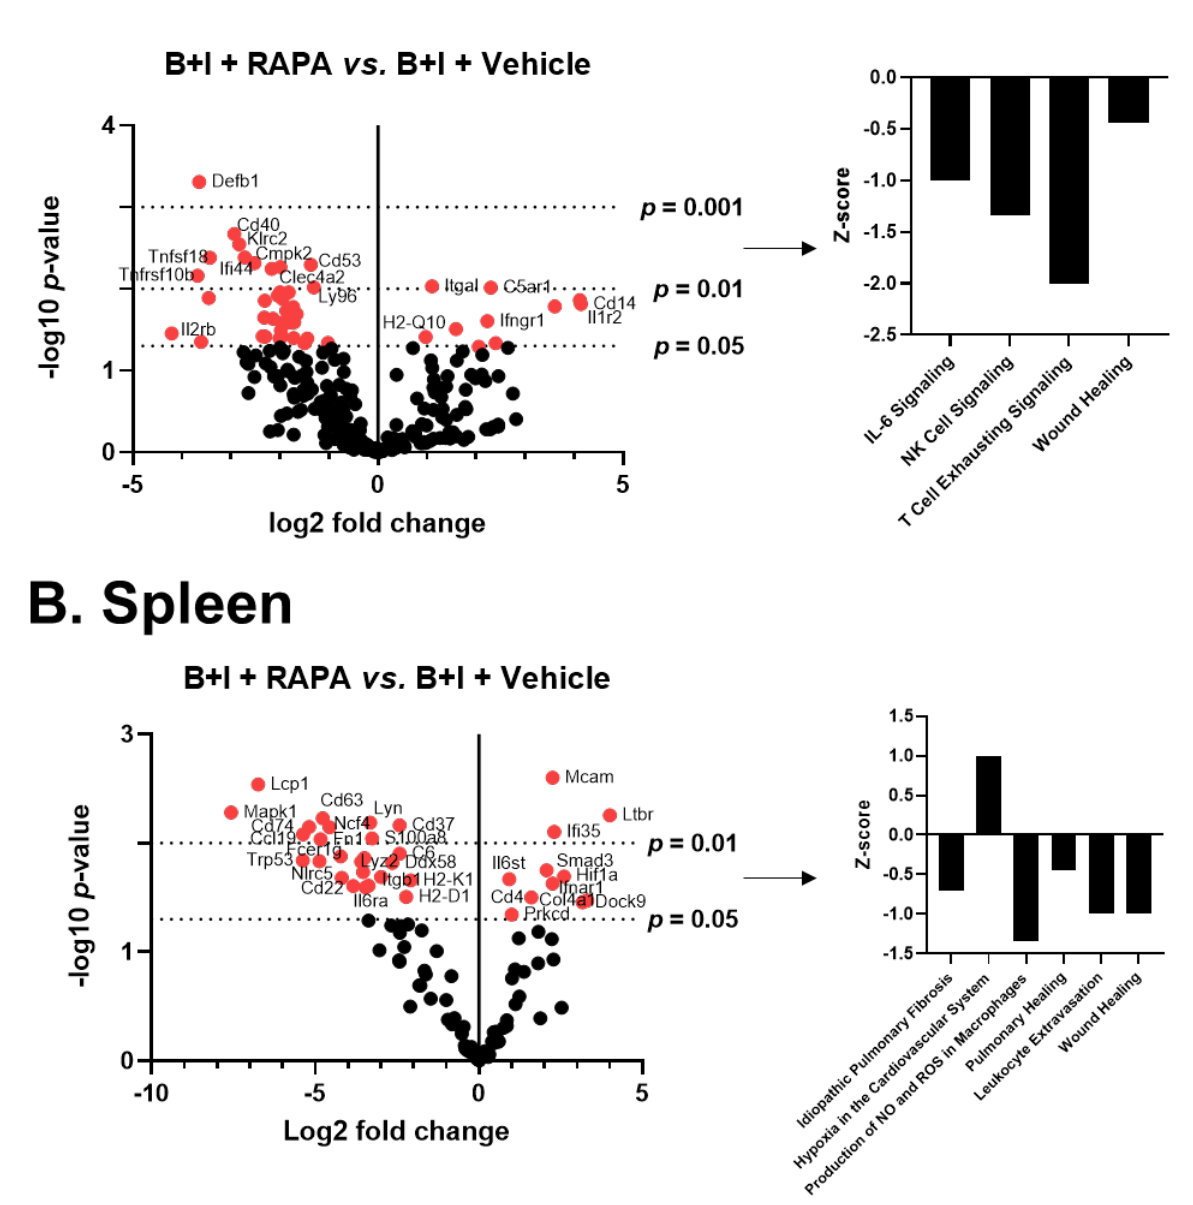
Figure 7. mTOR inhibition via rapamycin at the time of injury induced early differential gene expression and canonical pathway activity in B+I mice compared to vehicle controls. Mice were administered either rapamycin or vehicle pretreatment for 7 days before receiving B+I injury (n = 6 per group). mRNA was extracted from ( A ) whole lung and ( B ) spleen tissue and run on NanoString. Differential gene expression and pathway Z-scores were analyzed via nSolver and Ingenuity Pathway Analysis, respectively. Volcano plots are of rapamycin-induced differential lung gene ex- pression after B+I + rapamycin (“RAPA”) vs. B+I + vehicle controls, where red dots signify p < 0.05 (–log10( p -value) > 1.301). For the Z-plots, only significantly altered ( p < 0.5) pathways are shown. These data reveal that following B+I injury, the mTOR blockade at the time of